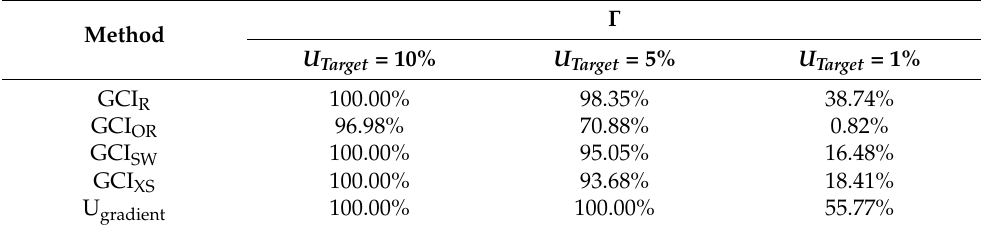
Table 6. The precision test result of the simulation of a flow passes through a cylinder.